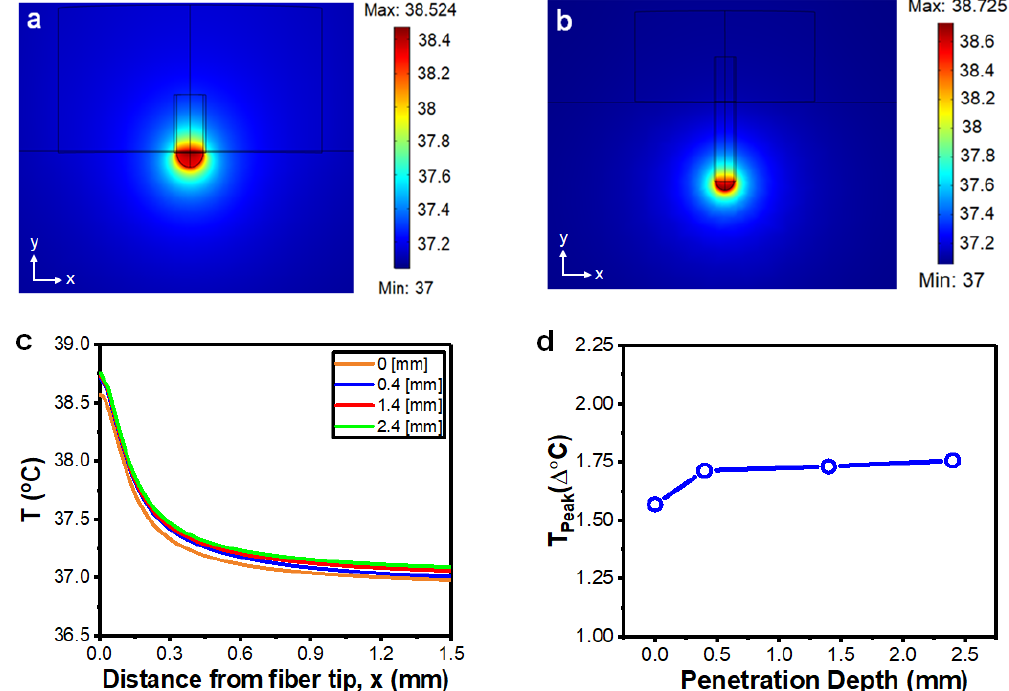
Figure 6 . Temperature analysis of photothermal effect using TP optical fiber in the brain covered with the skull and scalp. ( a , b ) Top-view and cross-sectional view of the temperature distribution in the brain by the optical fiber. Penetration depths were set each to 0 and 1.4 mm, and the heat rate was set to 1 mW for 20 s. ( c ) Temperature distribution of the TP optical fiber with different penetration depths. ( d ) Temperature changes of TP optical fiber with different penetration depths (heat rate: 1 mW; laser irradiation: 20 s).